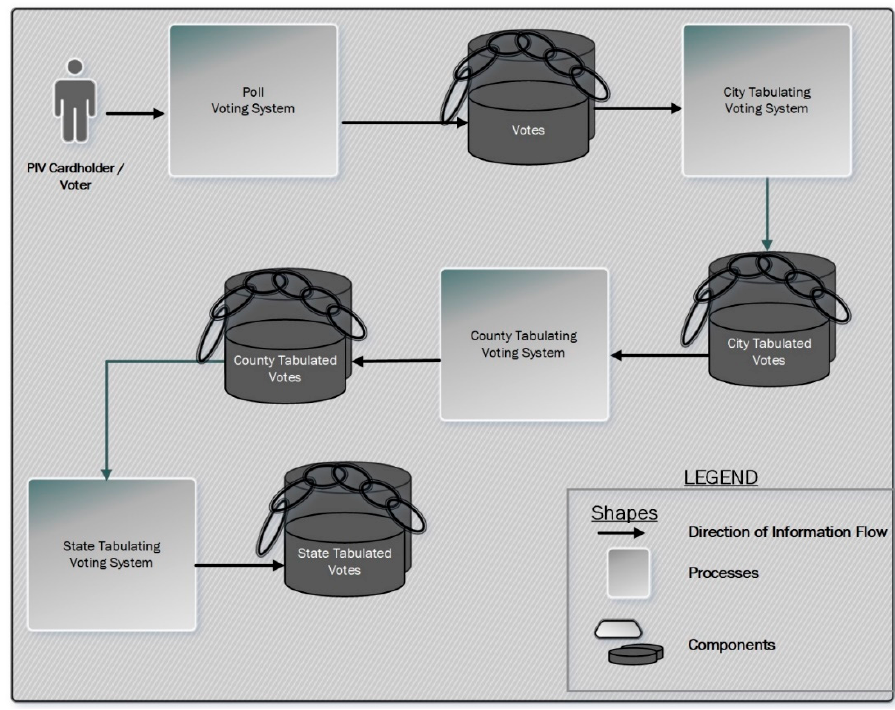
Figure 2. BPES city, county, and state integration.